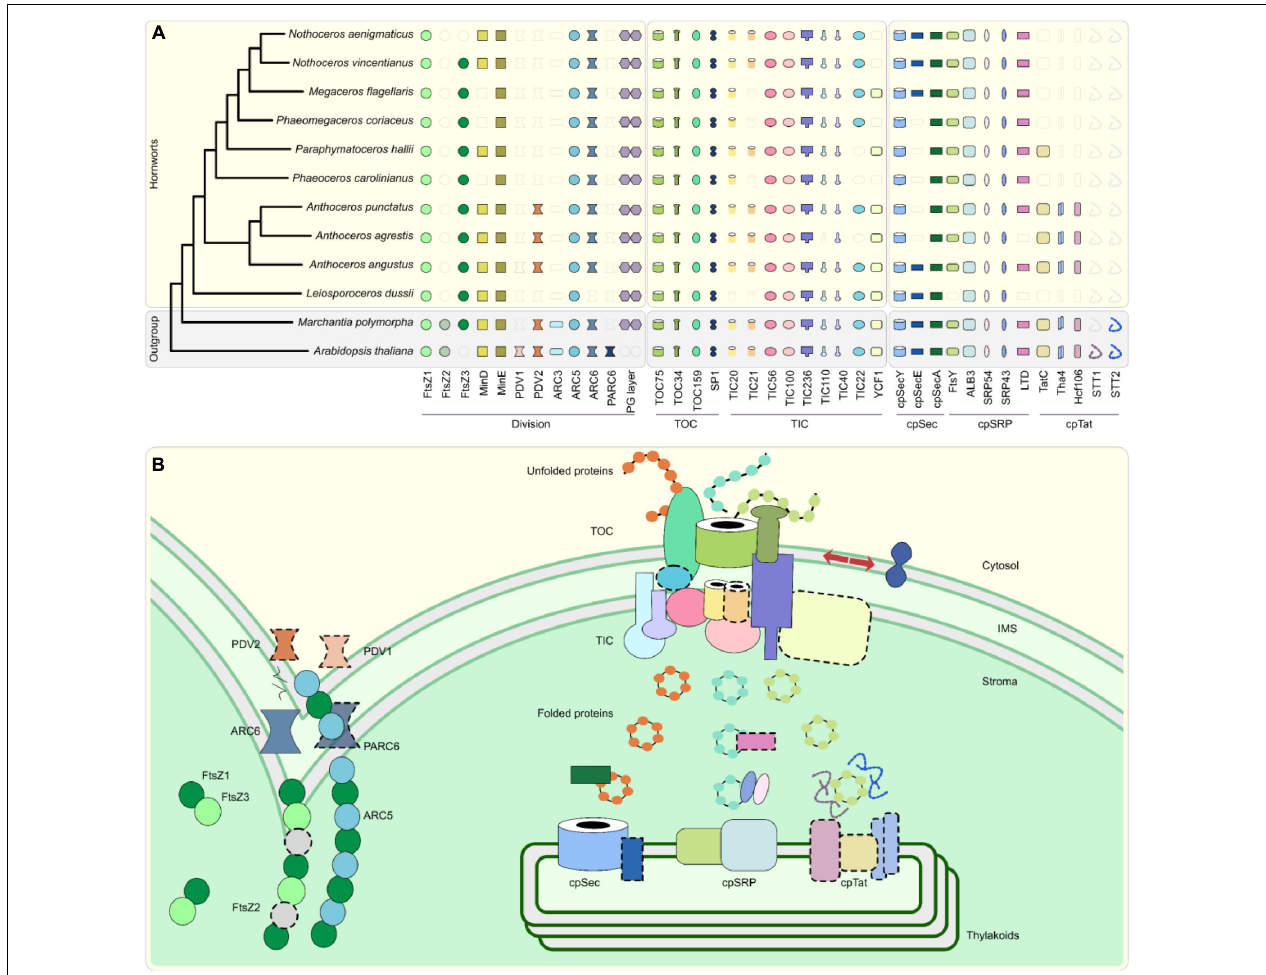
FIGURE 1 | Plastid development and biogenesis in hornworts. (A) A presence/absence pattern (PAP) of various plastid developmental components that are sorted into three categories based on whether they are associated with plastid division (PD) and protein translocation across the plastid envelope via TOC/TIC or the thylakoid membrane. Transparent icons indicate that no gene could be identified. (B) A combined schematic representation of plastid development in embryophytes. Components that are absent from more than two hornworts in our surveyed taxa, or absent in this group altogether, are highlighted by dotted outlines. ARC, accumulation and regulation of chloroplasts; FtsZ, filamentous temperature Z; IMS, intermembrane space; Sec, secretory; SRP, signal recognition particle; Tat; twin arginine translocation; TOC/TIC, translocator of the outer/inner chloroplast membrane; PDV, plastid division. While ARC5 is absent from the Anthoceros agrestis Bonn ecotype, which we included in our OrthoFinder analyses as the representative for this species, our reciprocal best hit pipeline confirmed that it is present in the Oxford ecotype, with its gene ID being AagrOXF_evm.TU.utg000081l.174. A maximum likelihood (ML) tree was constructed via the IQ-TREE version 2.0.3 software (Minh et al., 2020), using an automated selection model, by concatenating single-copy chloroplast and mitochondrial markers from 65 different hornwort species, and three outgroups (Villarreal and Renner, 2012). Said sequences were aligned with MUSCLE in AliView (Edgar, 2004; Laarson, 2014). Gene trees for orthologs listed on the PAP were generated using the PhyML version 3.0 and IQ-TREE version 2.0.3 softwares using automated selection models (Guindon et al., 2010; Lefort et al., 2017). We used the SHOOT framework (Emms and Kelly, 2021) to extract orthologous sequences from across the Archaeplastida for said trees. We analyzed the genomes and transcriptomes of ten hornworts, along with the genomes of Arabidopsis thaliana and Marchantia polymorpha , to determine the presence of various components involved in plastid development (Lamesch et al., 2012; Bowman et al., 2017; Leebens-Mack et al., 2019; Li et al., 2020; Zhang et al.,